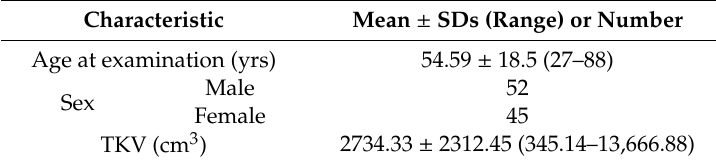
Table 1. 110 Contrast-enhanced Computed Tomography (CCT) acquisitions from 97 ADPKD